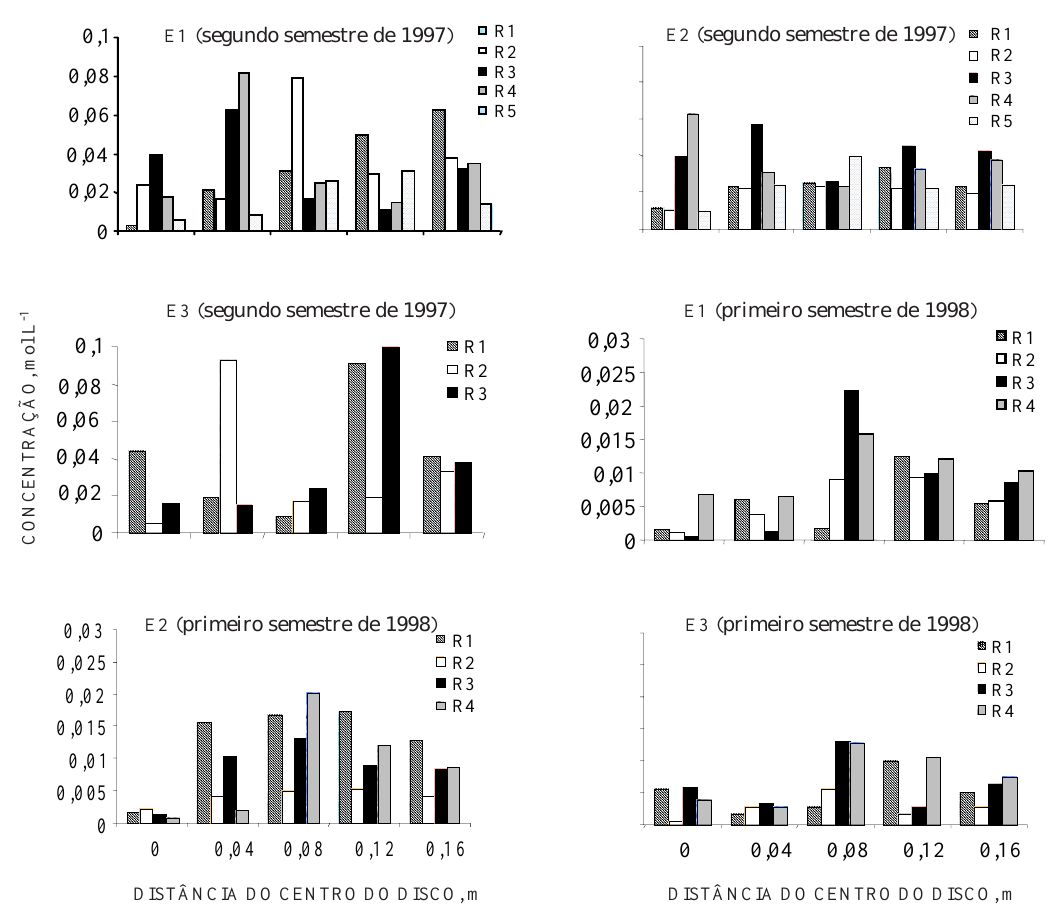
Figura 4. Distribuição da concentração de Cl - em função da distância do centro do disco, para as concen- trações dos tratamentos do segundo semestre de 1997 (concentração de 0,1 mol L -1 ) e primeiro semestre de 1998 (concentração de 0,05 mol L -1 ), nas três parcelas estudadas (E1, E2 e E3). R1, R2, R3, R4 e R5 referem-se aos ensaios dos